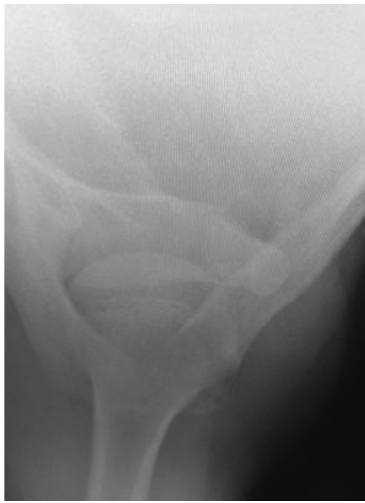
Figure 6: Case B: axillary radiograph at 12 weeks